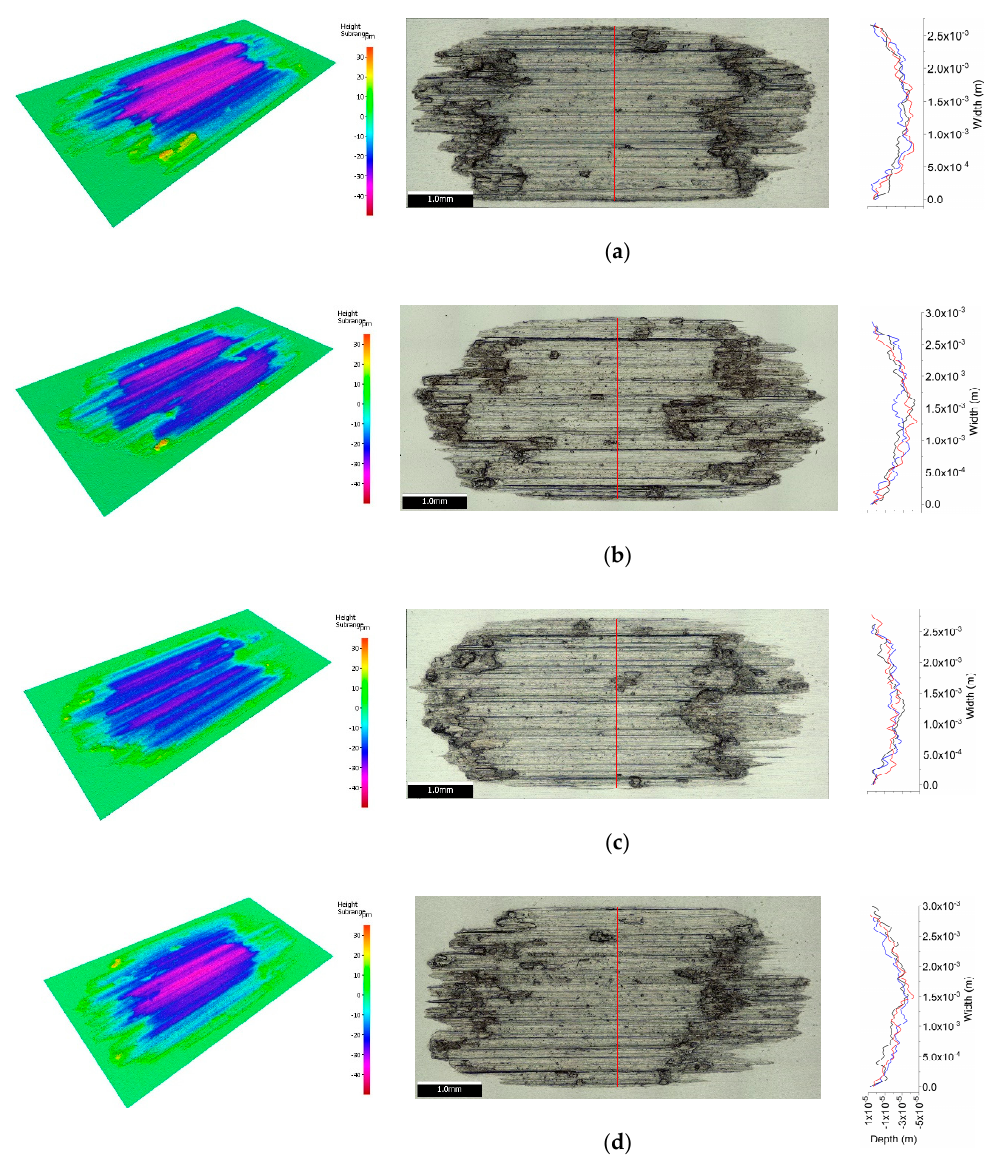
Figure 7. Pseudo-color 3D depth images, optical images, and depth profiles of three wear tracks in ( a ) As-cast material; Material aged at 800 ◦ C for ( b ) 100 h; ( c ) 500 h; ( d ) 1000 h.